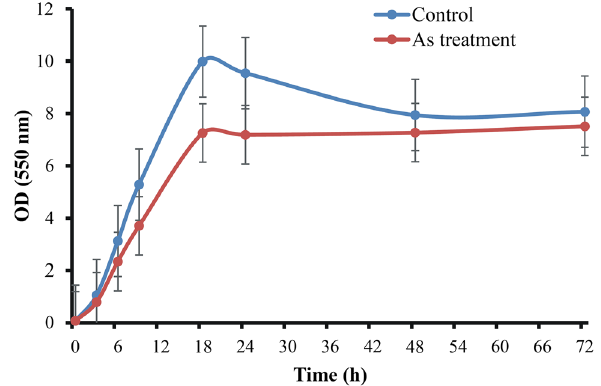
Fig. 2 Growth pattern of selected As-resistant LAB isolate HS12 showing growth inhibition of HS12 in As-supplemented MRS medium compared to that of the control